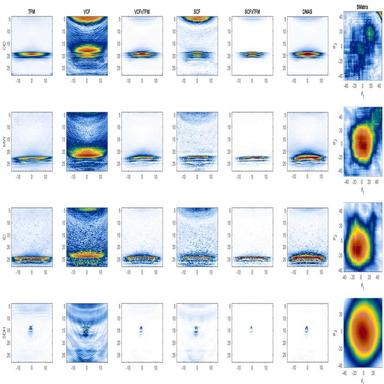
TFM, VCF, VCFxTFM, SCF, SCFxTFM, DMAS and scattering matrix for OD, MW, ID samples and SDH from a calibration bloc.